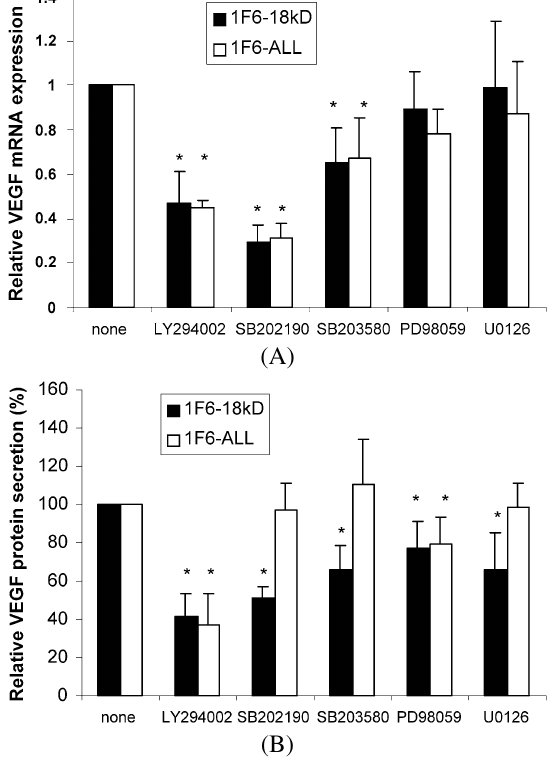
Fig. 7. Effect of PI-3K, p38 and ERK1/2 inhibitors on VEGF mRNA production (A) and protein secretion (B). Cells were incubated in serum-free medium for 24 h in the absence or presence of 40 µM LY294002, 10 µM SB202190, 10 µM SB203580, 50 µM PD98059 or 10 µM U0126 for 24 h. VEGF mRNA production was determined by light-cycler RT-PCR and relative expression in untreated cells was set at 1. VEGF protein secretion in conditioned medium was deter- mined by ELISA, cells were counted and results were expressed in pg/ml/10 6 cells. Values in untreated cells were set at 100%. The ex- periments were carried out at least three times. Bars represent mean values ± SD. *Indicates a significant difference ( p < 0 . 05) as com- pared to untreated